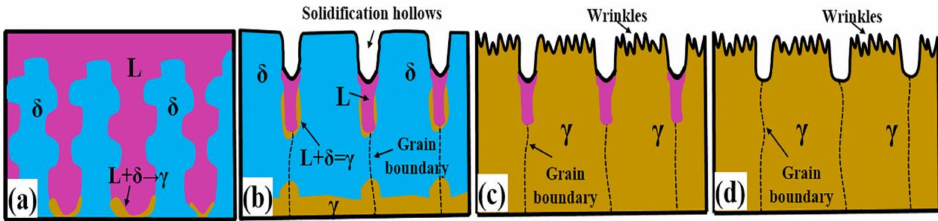
Figure 4. Schematic diagram of the surface solidifying process for hypo-peritectic steels. ( a ) Peritectic reaction; ( b , c ) Before and after δ – γ transformation; ( d ) Solidification finished.